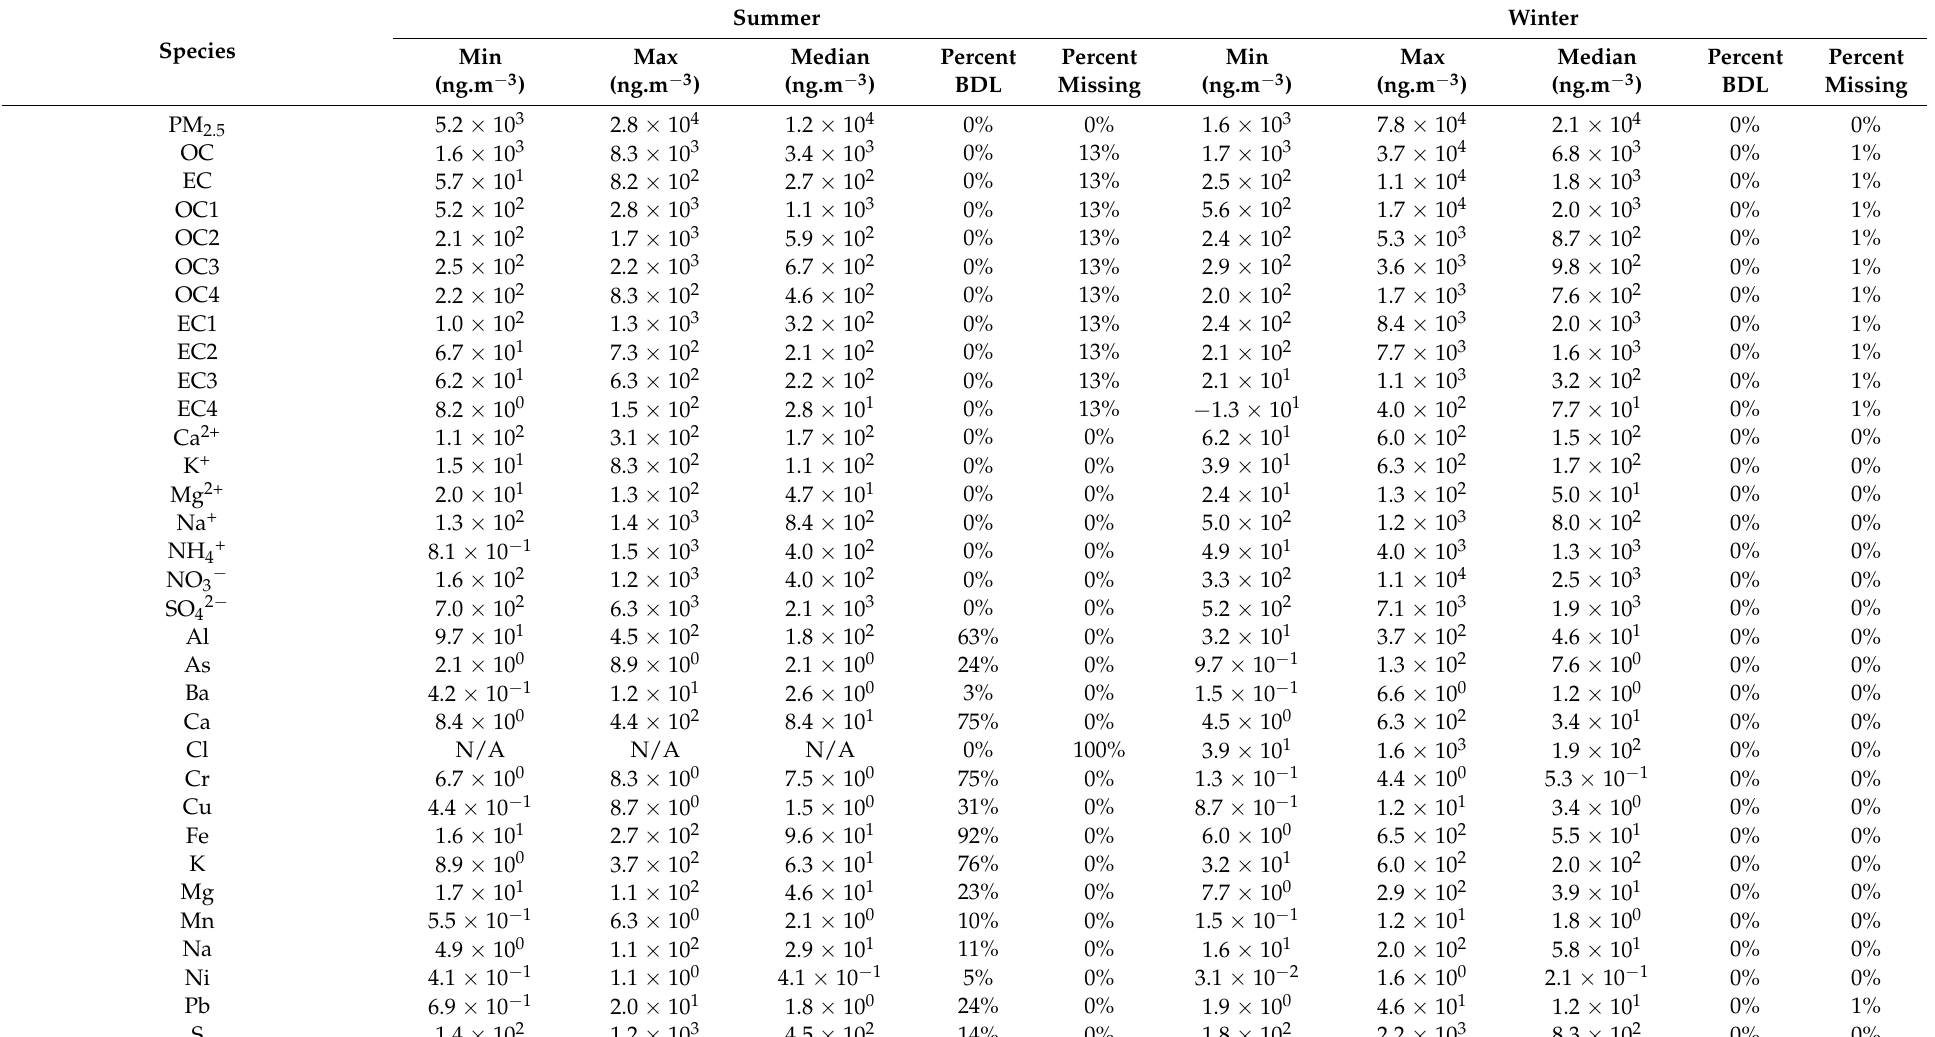
Table 1. Species quantified in this study (summary of all three sampling sites). BDL: Below detection limit; N/A: no data available.